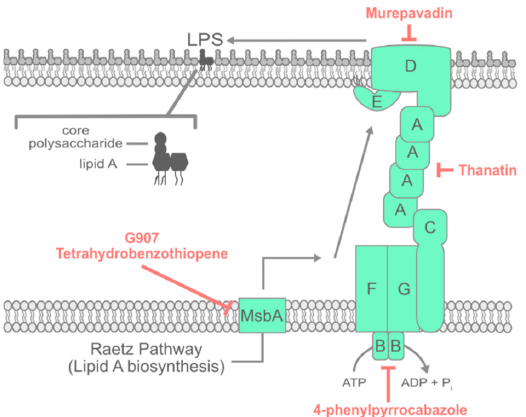
Figure 2. Lipopolysaccharide (LPS) biogenesis and its inhibitors. LPS is composed of lipid A, core polysaccharides, and the O antigen (not pictured). In the cytoplasm, lipid A is synthesized via the Raetz pathway. The flippase MsbA translocates LPS across the IM bilayer. The ATP-binding cassette (ABC) transporter LptB 2 FG extracts LPS molecules from the periplasmic leaflet of the IM. LPS travels from LptC, across an LptA bridge, and is received by LptD at the OM. LptDE facilitates the insertion of LPS into the OM. Red labels indicate compounds that are active against steps of LPS biogenesis and